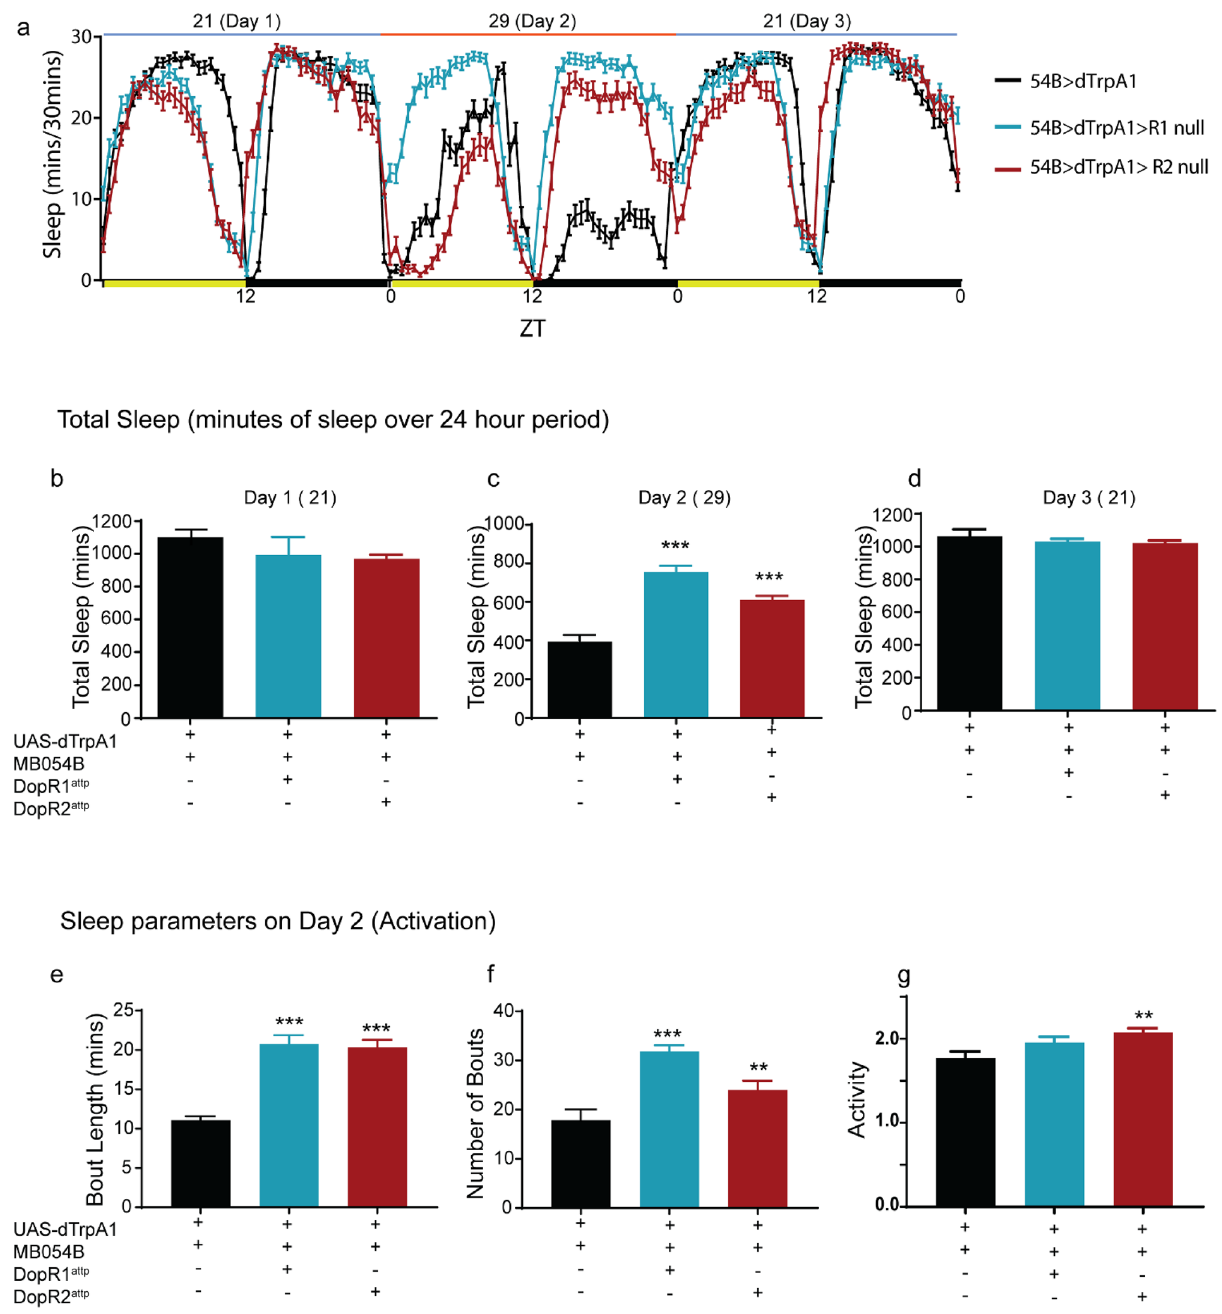
Figure 8. Wakefulness induced by PAM γ5 dopamine activation requires both DopR1 and DopR2 function. ( a ) 3-day Sleep profile of flies expressing temperature sensitive cation channel dTrpA1 in PAM γ5 DANs (MB054B) in the wild type, DopR1 and DopR2 hypomorph backgrounds. Day 1 represents baseline at 21 °C, Day 2 represent activation at 29 °C and Day 3 represents recovery at 21 °C. ( b – d ) Total sleep during Day 1 (baseline, 21 °C), Day 2 (activation, 29 °C) and Day 3 (recovery, 21 °C), of flies expressing dTrpA1 in PAM γ5 in positive control (w 1118 ) and receptor hypomorph background (DopR1 attp and DopR2 attp ). ( e , f ) Average sleep bout duration and number of bouts on Day 2 (activation, 29 °C) of flies expressing dTrpA1 in PAM γ5 in positive control (w 1118 ) and receptor hypomorph background (DopR1 attp and DopR2 attp ). ( g ) Activity or average beam crossings/waking minute, a measure of locomotor activity for all tested genotypes. For each of the experimental groups tested we had 59–61 flies which represented 2 independent experimental trials, sample included MB054B > dTrpA1 (59), MB054B > dTrpA1 > DopR1 attp (59) and MB054B > dTrpA1 > DopR2 attp (61). Data represents mean and SEM, * indicates p < 0.05, ** indicates p < 0.001 and *** indicates p < 0.0001. Statistical analysis was one-way ANOVA and Dunnett’s paired comparison with control for ( b , c , d , g ) and Kruskal–Wallis non-parametric one-way ANOVA and Dunn’s post-hoc correction for ( e , f